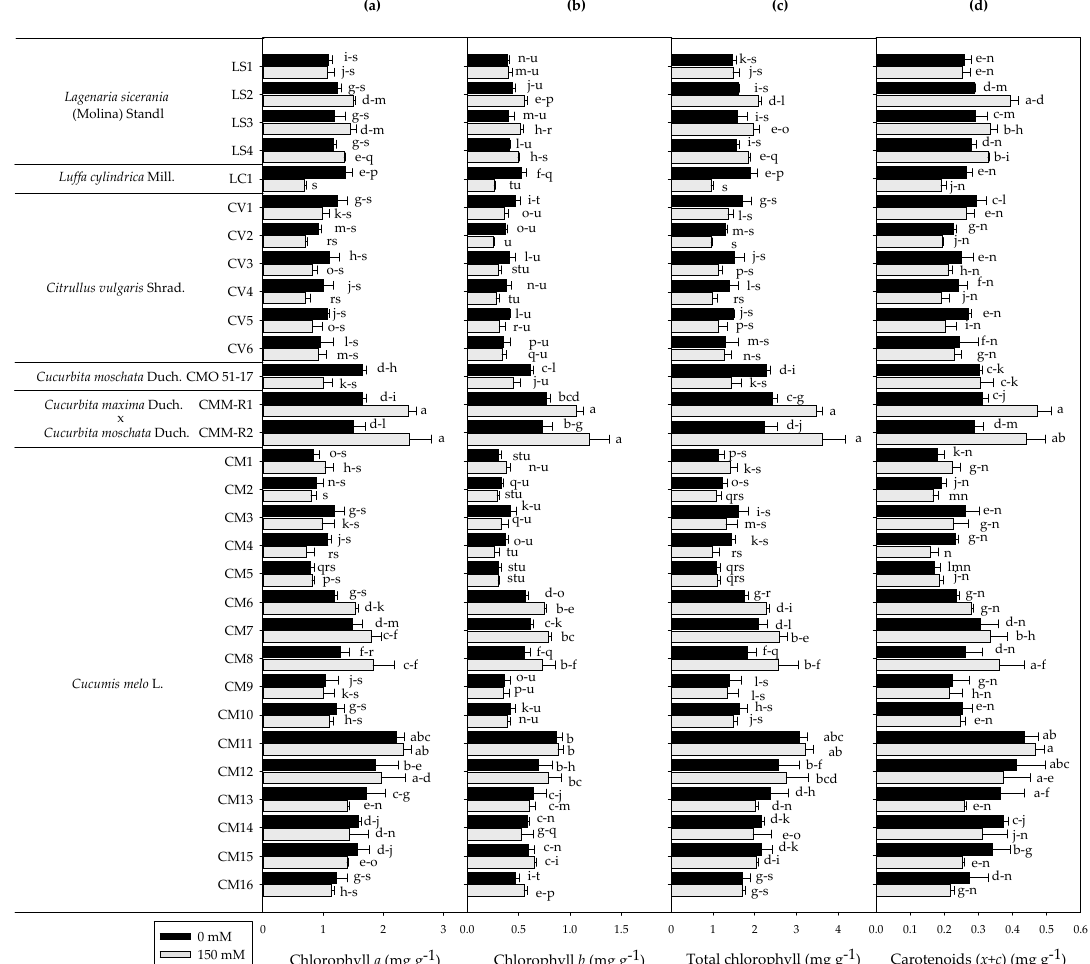
Figure 3. Photosynthetic pigment content, after one week of NaCl treatment, in term of chlorophyll a ( a ), chlorophyll b ( b ), total chlorophyll ( c ), and carotenoids ( x + n ) (d) in seedlings of sixteen Cucumis melo L., six Citrullus vulgaris Schrad., two C. maxima x C. moschata , four Lagenaria siceraria (Molina) Standl. different genotypes, and Cucurbita moschata Duch. cv 51–17 and Luffa cylindrica Mill. Mean values ± standard errors; n = 3 followed by different letters within each parameter are significantly different based on Duncan post hoc ( p < 0.05).